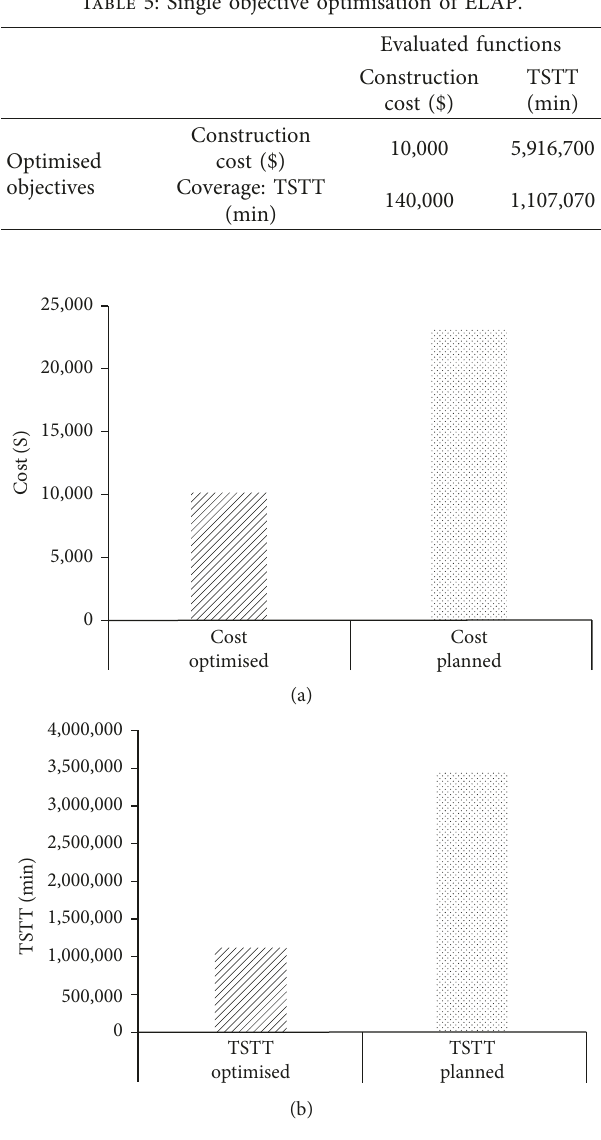
Figure 4: Contrasting optimised and planned solutions in terms of (a) cost and (b) TSTT.